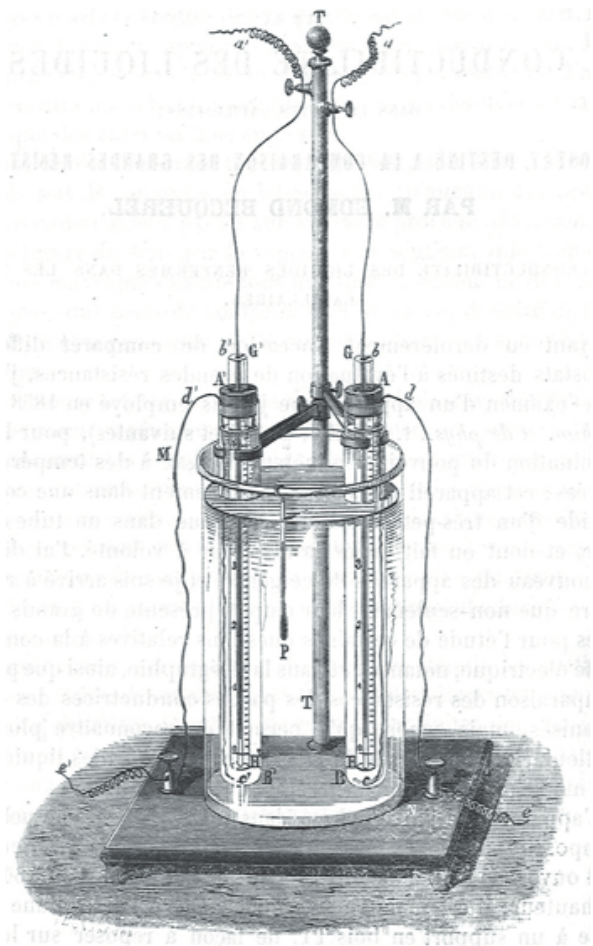
Figure 8. The rheostat constructed by Edmond Becquerel in 1861 for the first capillary electrophoresis of ions. [187] Explanations are includ- ed in the main text. Reproduced from Cnum – Conservatoire numé- rique des Arts et Métiers – http://cnum.cnam.fr with